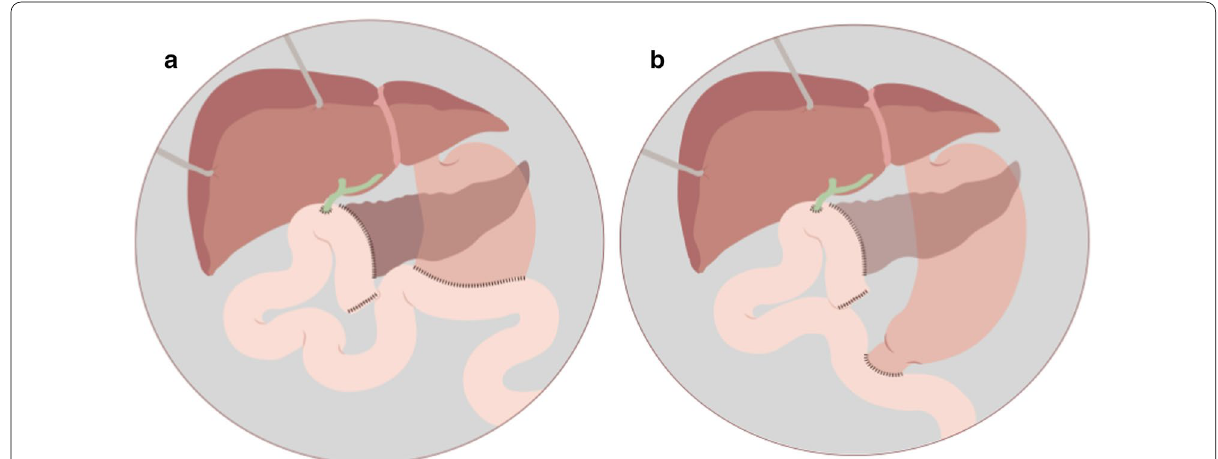
Fig. 1 Pancreaticoduodenectomy: ( a ) Classic procedure (Whipple’s) ( b ) Pylorus-preserving procedure